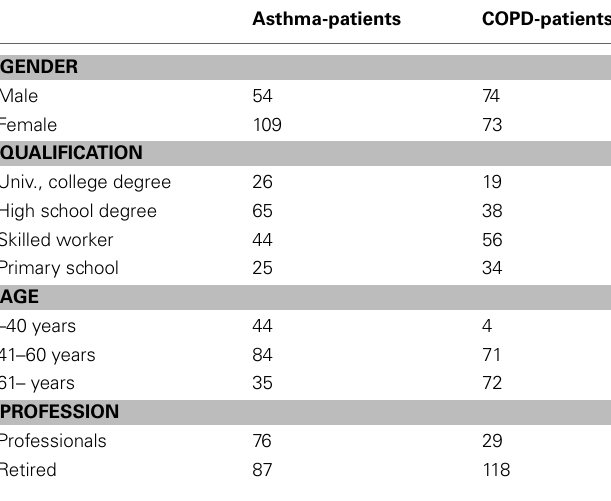
Table 1 | Distribution of sample according to the socio-demographic characters of patients